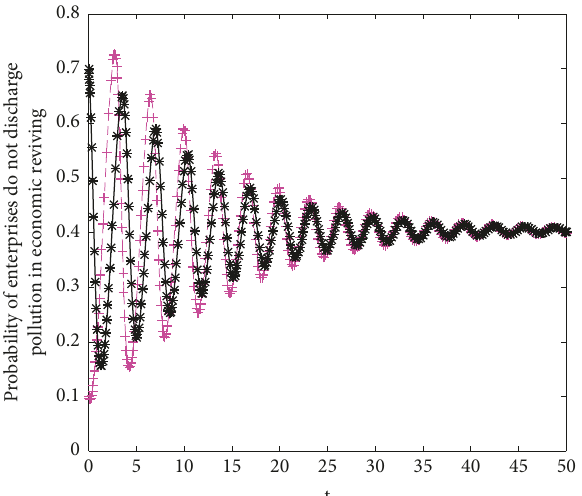
Figure 8: The evolution path of nondischarge in the process of enterprises economic revitalization under the dynamic incentives mechanism and penalties mechanism.